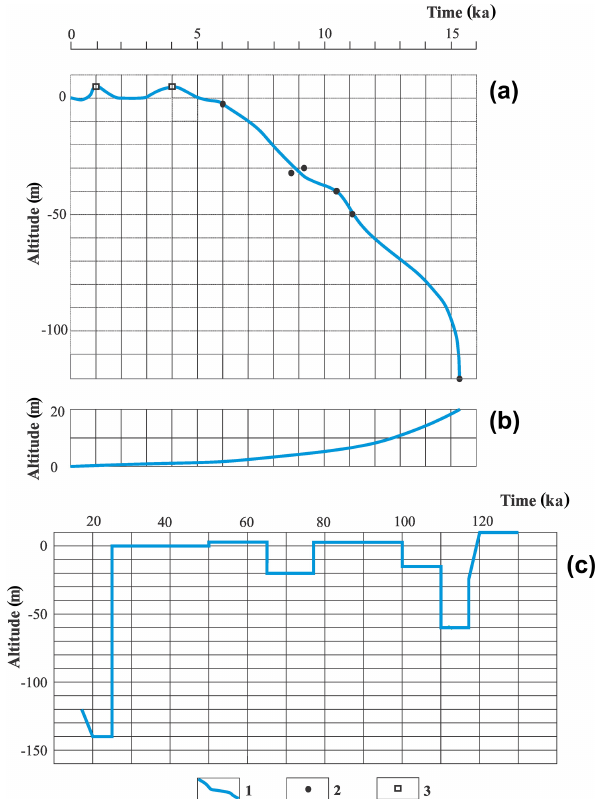
Figure 4. Scenarios of sea level fluctuations: for the 15–0ka (a) periglacial domain and (b) glacial domain, and for the 125–15ka (c) periglacial domain. 1 – sea level curve; 2 – dated bottom sedi- ment cores from the Gulf of Ob, Yenisei Gulf, and adjacent offshore (Stein et al., 2009) and Vilkitsky Strait (Levitan et al., 2007) sites; 3 – onshore data (Romanenko, 2012).